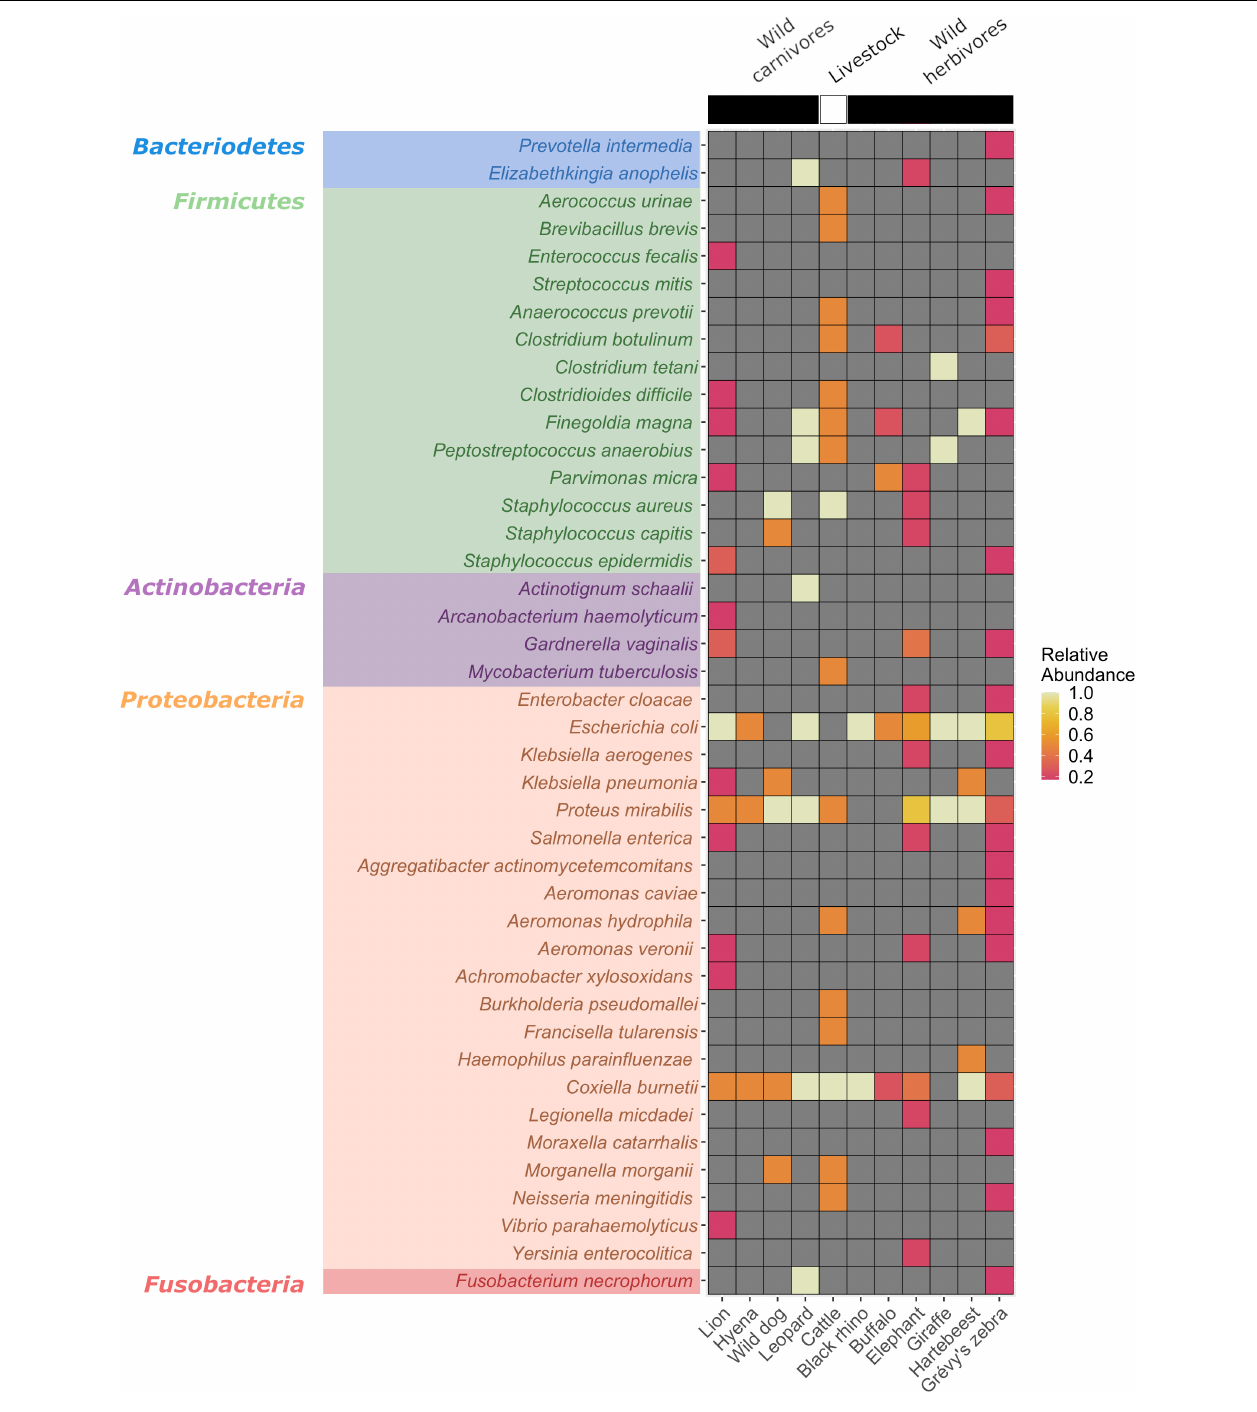
FIGURE 2 | Heatmap of the detected bacterial pathogens according to the hosts. Pathogen detection rates were calculated as positive tick pools divided by the number of hosts